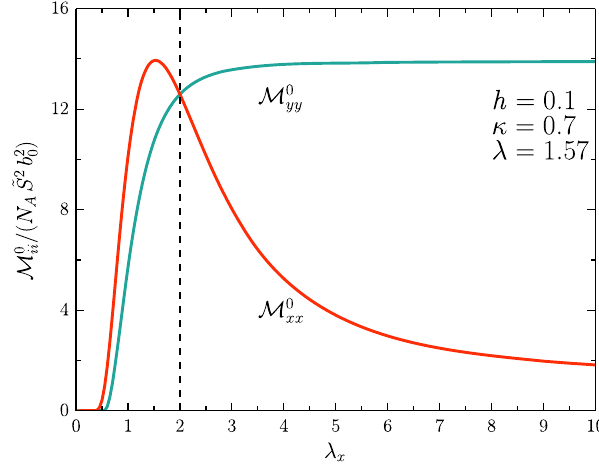
FIG. 6. Magnetic field dependence of the mass term M for spatially dependent periodic exchange interactions with 1 . 5 , J 0 . 1 , and T ¼ 0 . Inset (a) depicts the λ 2 depend- λ P ¼ P ¼ ence of M , while inset (b) illustrates M as a function of period λ for h ¼ 0 . 1 . P